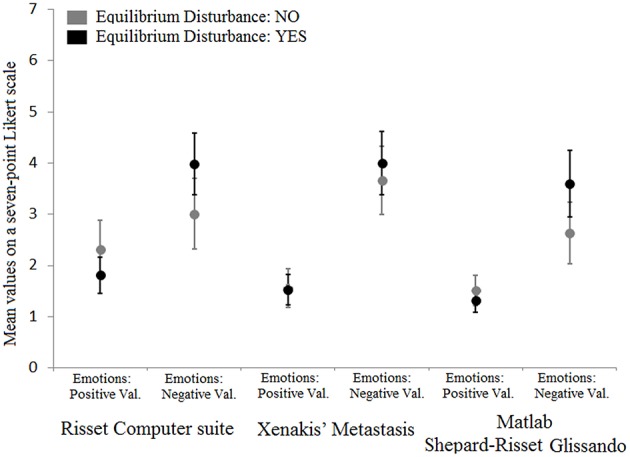
Mean values for emotions with positive and negative valence for each musical stimulus and for both subjects who experienced and did not experience a feeling of equilibrium disturbance while listening to the stimuli. Error bars represent standard deviations of the means.